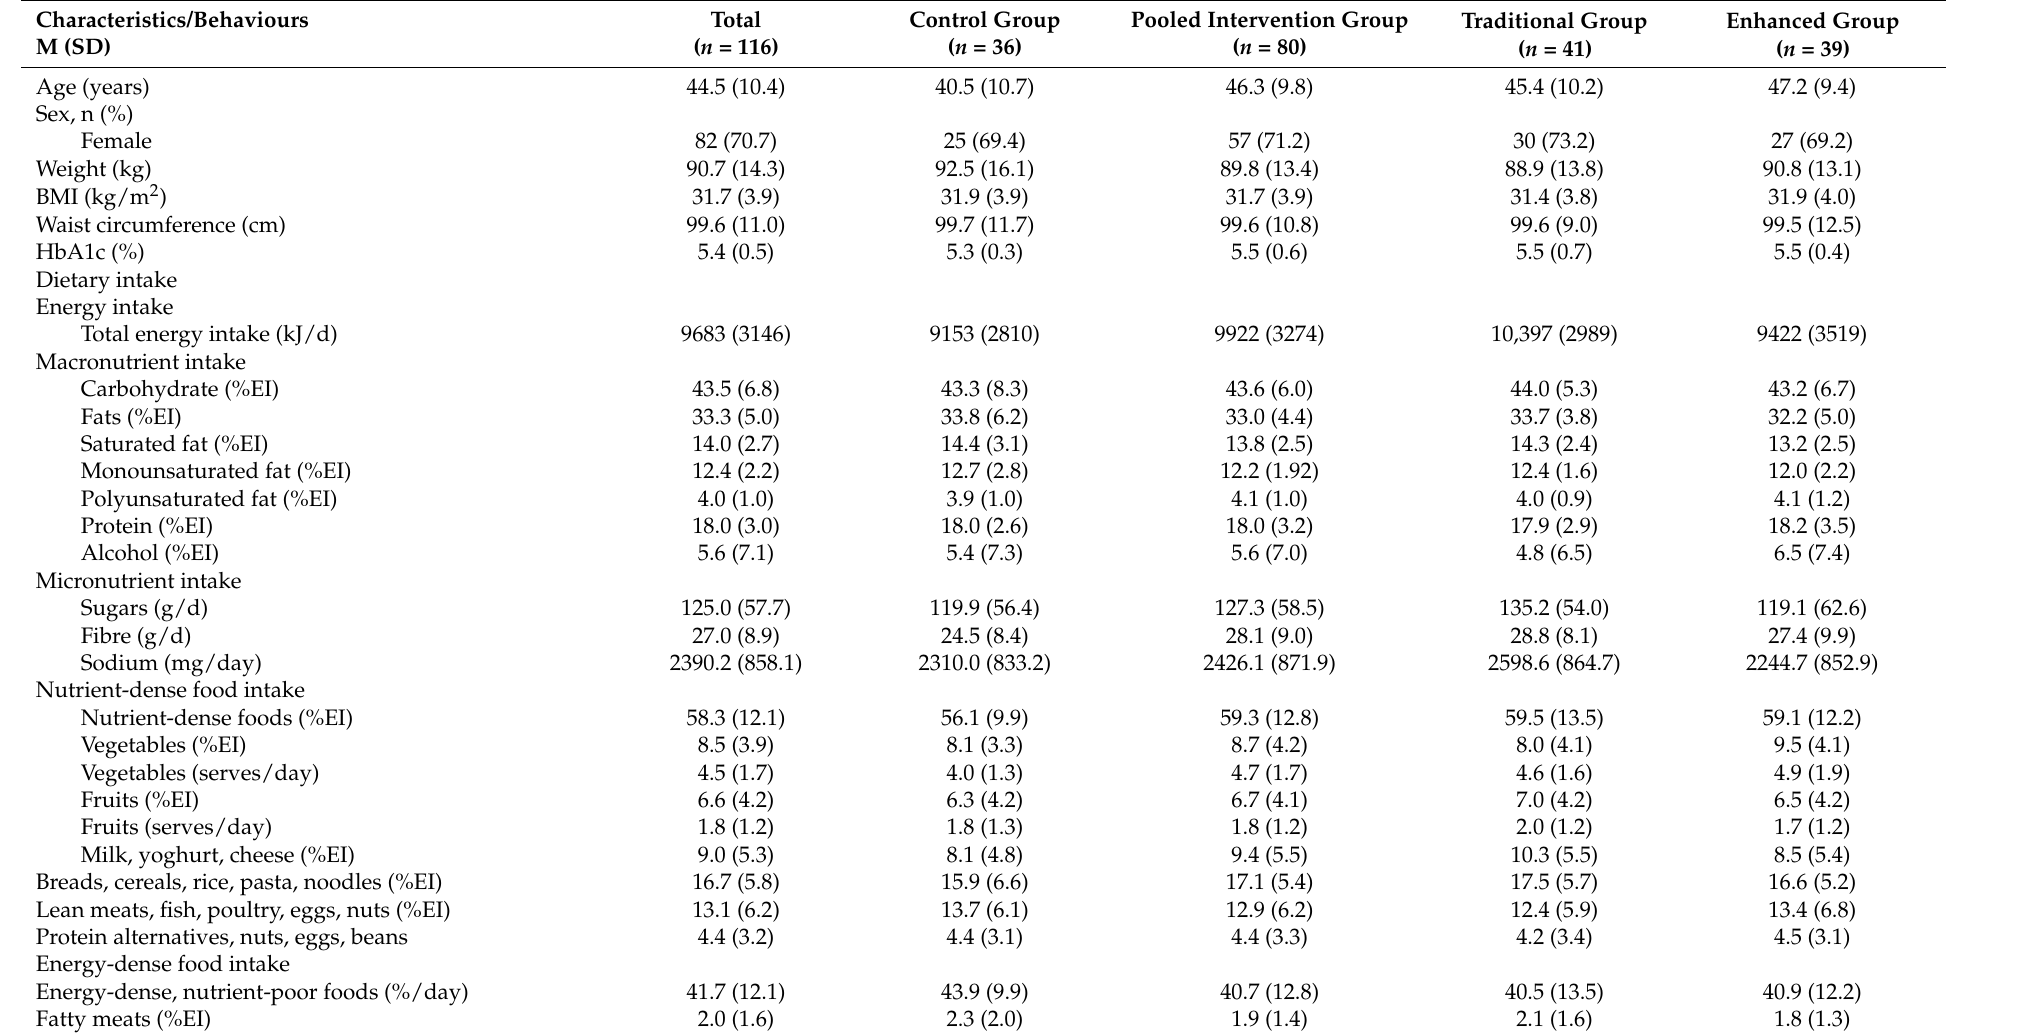
Table 1. Baseline sociodemographic, health, and behavioural characteristics of participants by